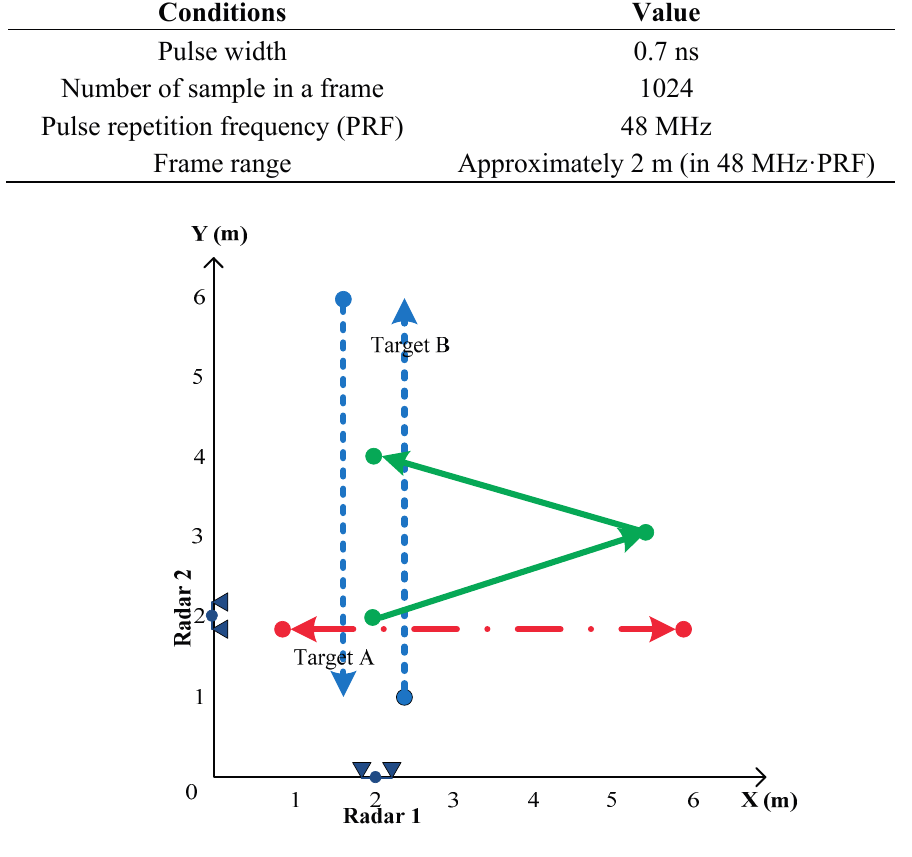
Figure 5. Locations of radars and the directions of target movement in the